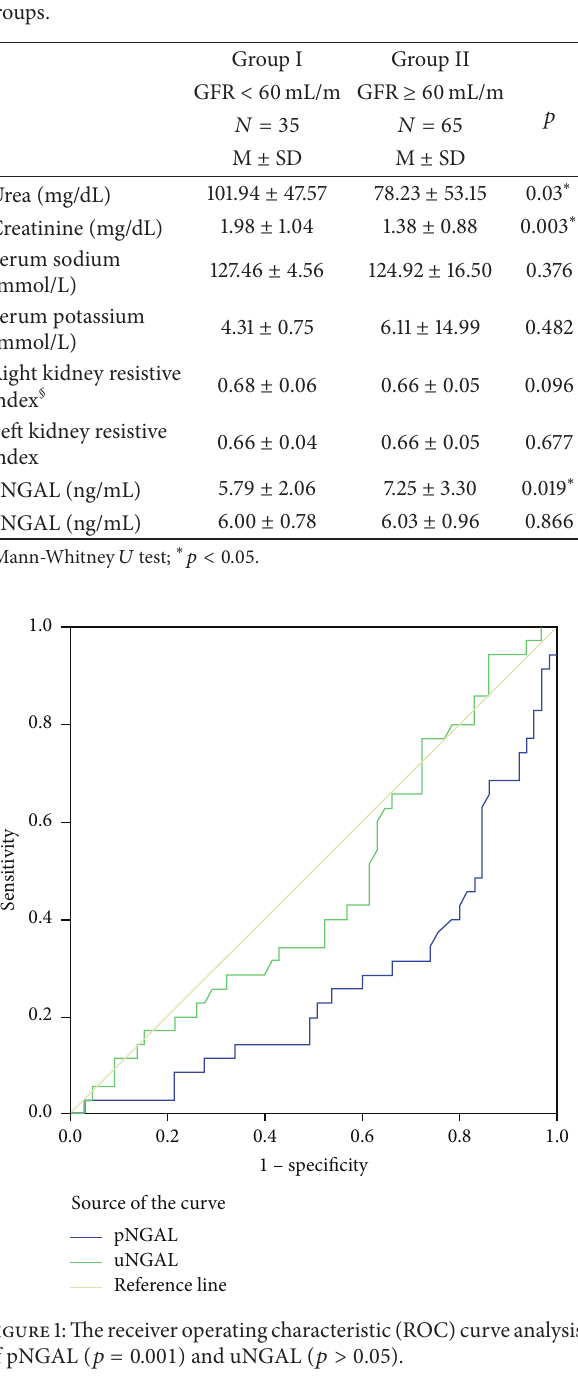
specificity and PPV = 29.1, NPV = 42.9, LR+ = − 5.11, and LR − = −